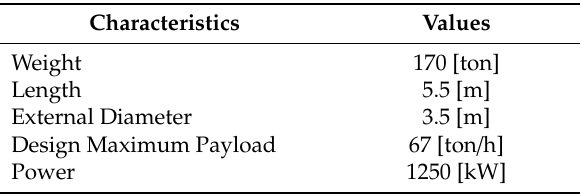
Table 7. Ball mill main characteristics.